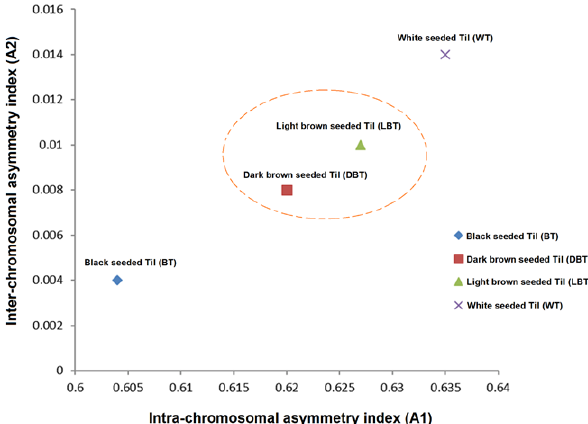
Figure 4. Scatter diagram of intra-chromosomal asymmetry index (A1) versus inter-chromosomal asymmetry index (A2) of four Indi- an landraces of S. indicum